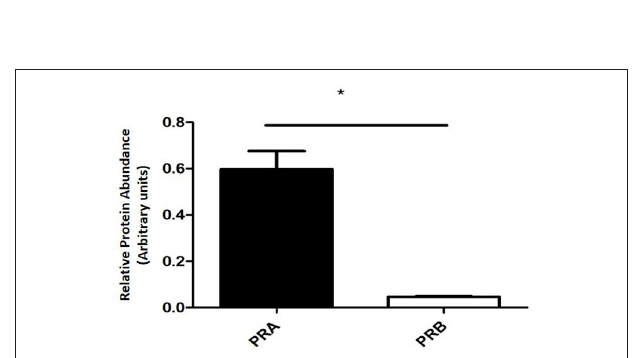
FIGURE 4 | PRA and PRB protein relative abundance of equine placental tissue samples at term (mean ± SEM, n = 6; normalized to β -actin; * P <